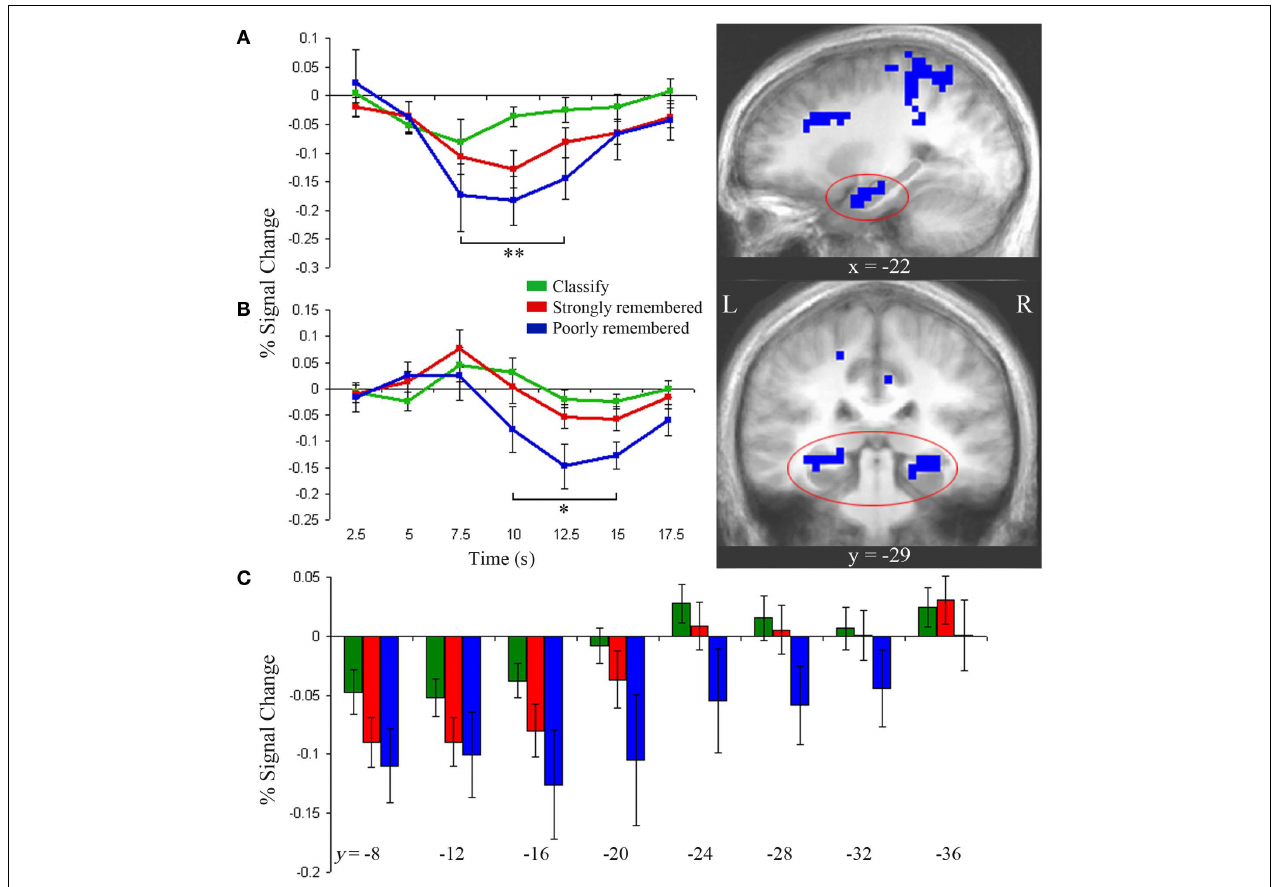
remembered trials ( p < 0.05). Impulse response curves reveal late deactivation for poorly remembered trials only. *Indicates poorly remembered < classify and poorly remembered < strongly remembered (paired t -tests, p < 0.01). (C) Bilateral hippocampus showed a gradient of decreasing deactivation, from 7.5 to 12.5s, from anterior to posterior regions. Each hippocampal subregion represents a 4-mm thick slice along the long axis of the hippocampus. Error bars represent SE of the mean. Subtraction maps are overlaid on sagittal (A) and coronal (B) slices of the average anatomical image of all